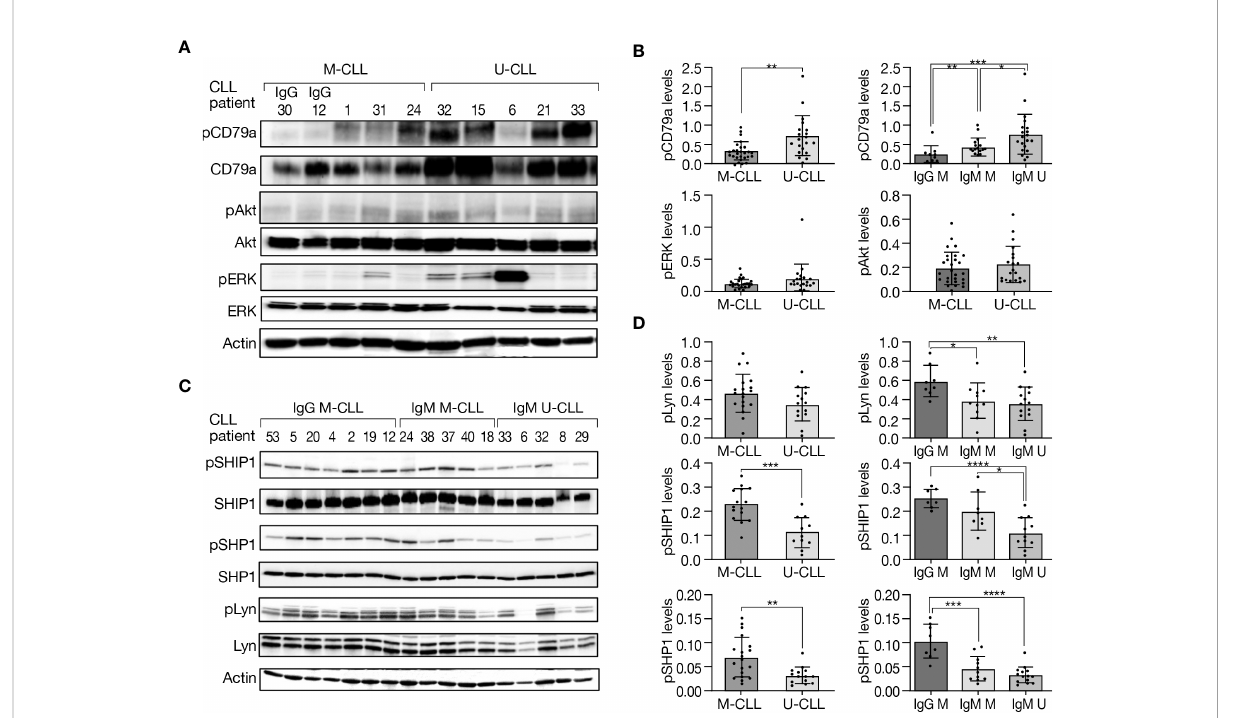
FIGURE 2 Basal phosphorylation levels of BcR signaling elements in M-CLL and U-CLL cells. (A) Representative Western blot analysis showing CD79a (Y182), Akt (S473), and ERK (T202/Y204) phosphorylation as well as total amount of these proteins. Actin was used to verify equal loading. (B) Quanti fi cation of pCD79a, pAkt, and pERK levels in (A) by normalization to actin using the myImageAnalysis ™ Software (n = 47). *p < 0.05, **p < 0.01, and ***p < 0.001. (C) A Western blot analysis showing SHIP1 (Y1020), SHP1 (Y564), and Lyn (Y396) phosphorylation, as well as total amount of these proteins. Actin was used to verify equal loading. (D) Quanti fi cation of pSHIP1 (n = 26), pSHP1 and pLyn (n = 33) in (C) by normalization to actin using the myImageAnalysis ™ Software. *p < 0.05, **p < 0.01, ***p < 0.001, and ****p <